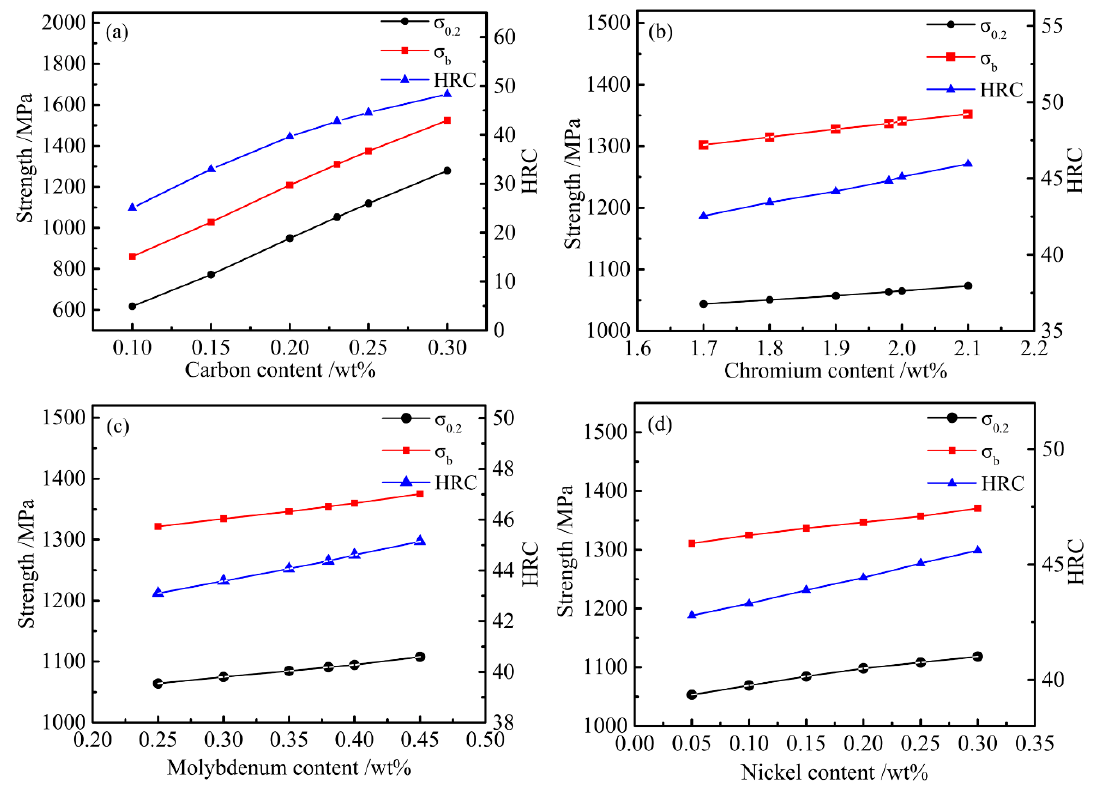
Figure 8. Influences of alloy content on the mechanical properties. ( a ) C; ( b ) Cr; ( c ) Mo; ( d ) Ni.